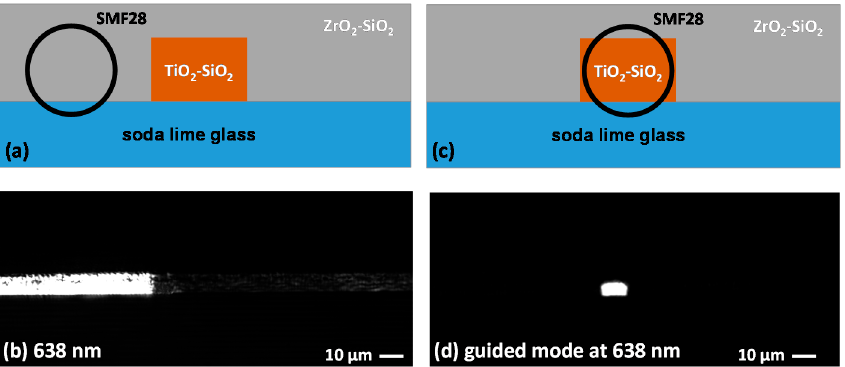
Figure 15. Injection of visible light (638 nm) in the architecture composed of the TiO 2 –SiO 2 core deposited on soda-lime glass and surrounded by the ZrO 2 –SiO 2 cladding. ( a ) Diagram of the SMF28 misaligned with the core, ( b ) corresponding output, ( c ) diagram of SMF28 aligned with the core and ( d ) corresponding guided mode. The SMF28 is schematized by black circles.